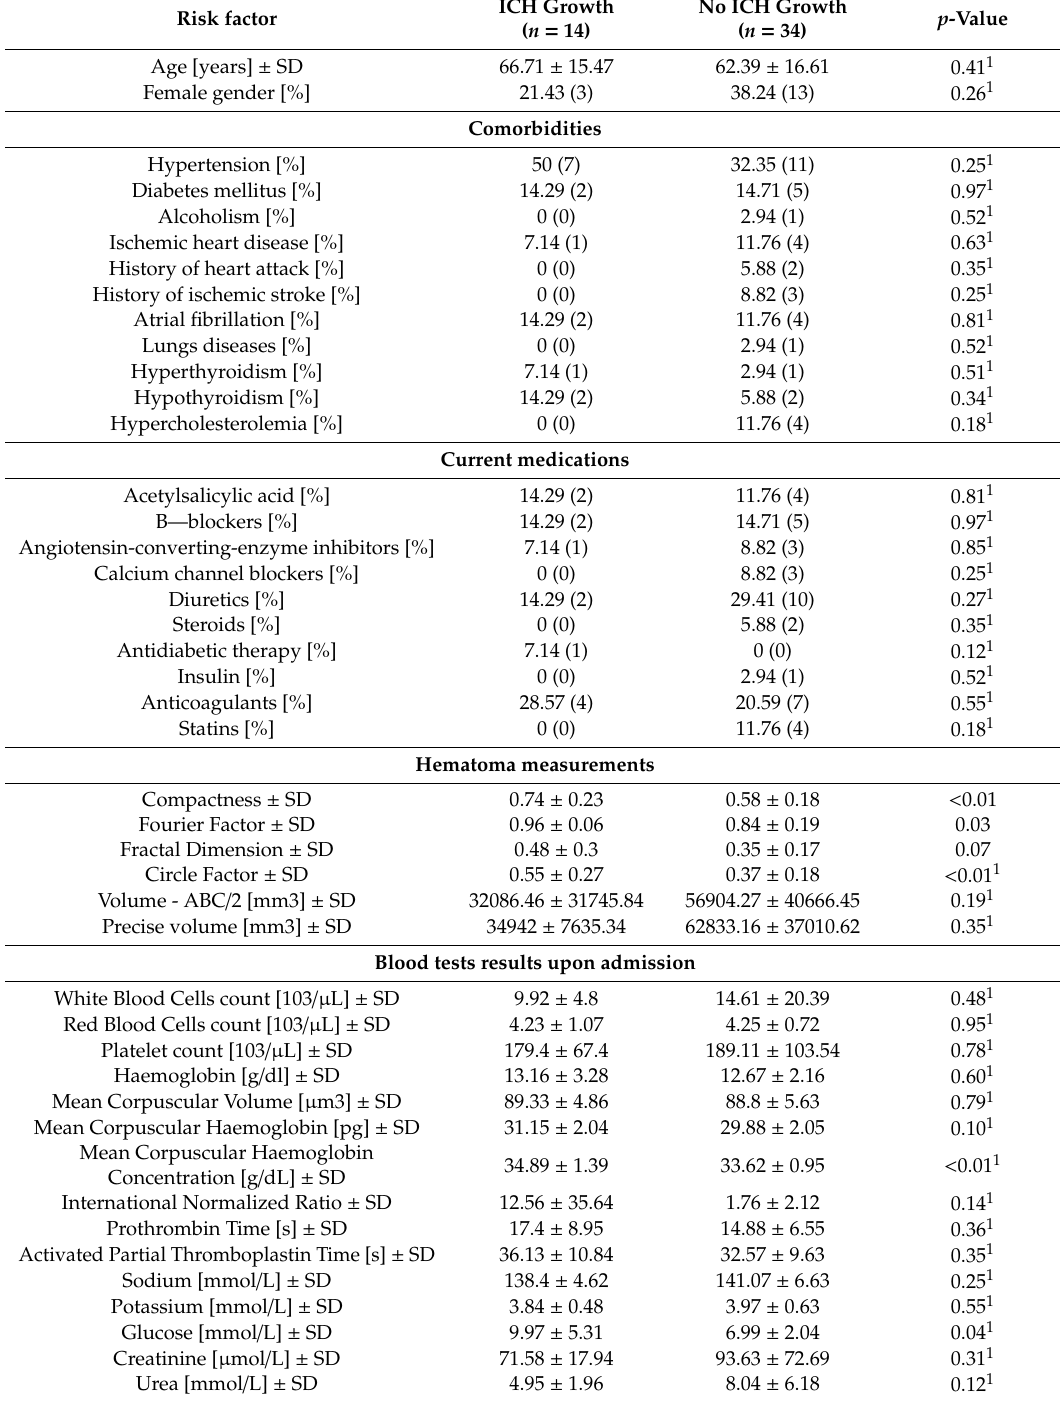
Table 2. Comparison of patients with and without ICH growth. SD—Standard